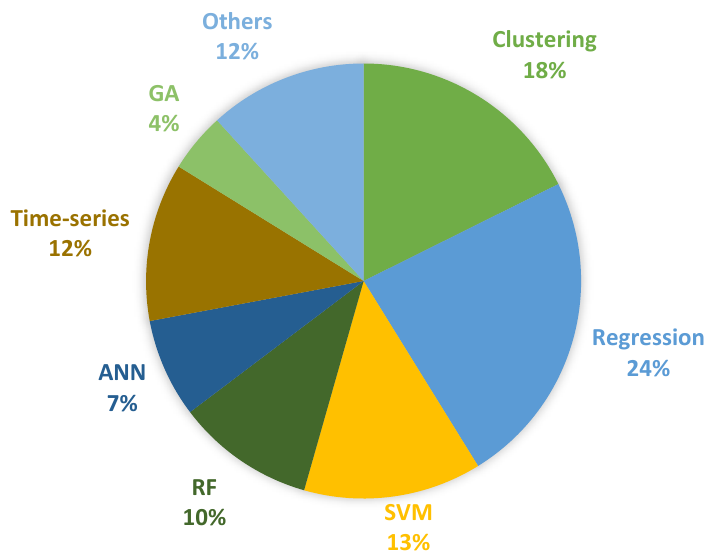
Figure 6. Widely used palm oil prediction algorithms.